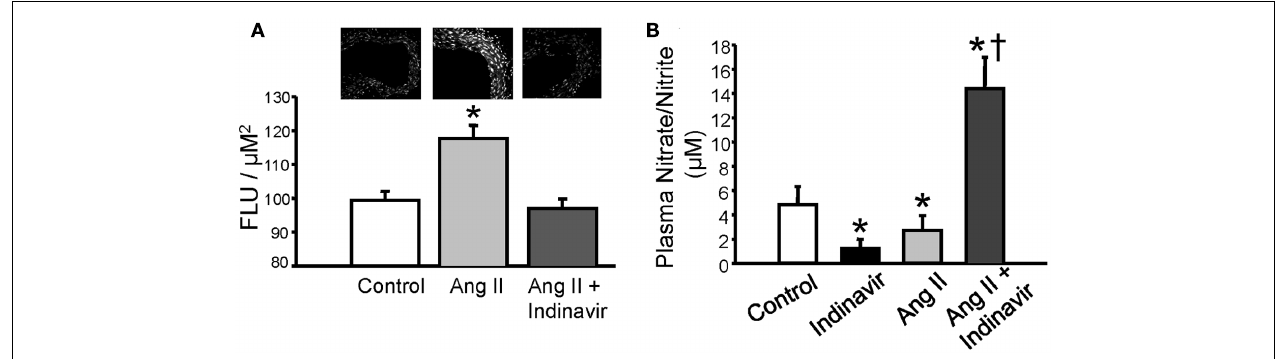
production which was normalized by moderate hyperbilirubinemia. (B) Moderate hyperbilirubinemia increases plasma NO levels in Ang II infused